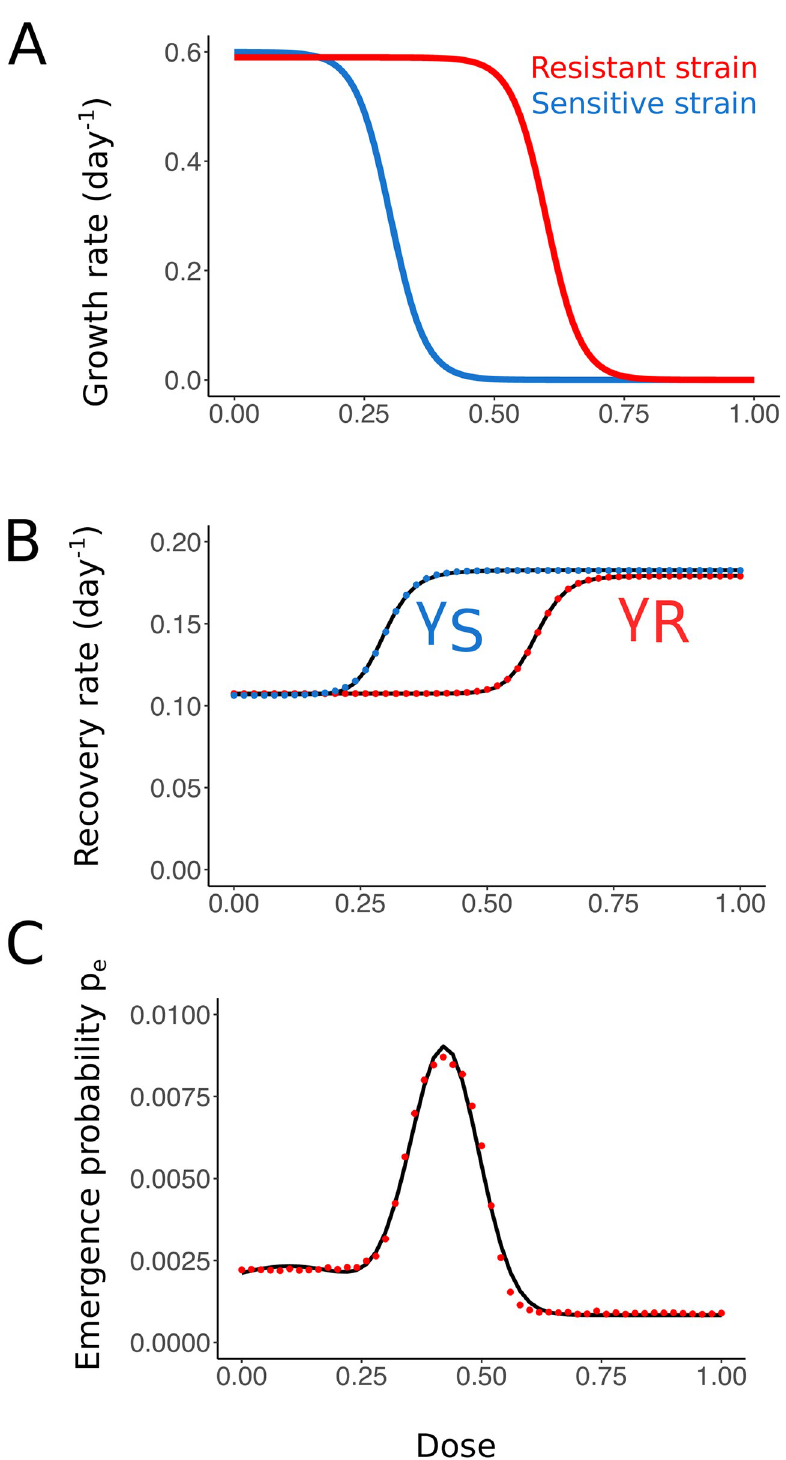
Fig 2. Transition from the nested agent-based model to an SIR model. (A) Effect of treatment strength on the growth rate for the sensitive and resistant strains. At very high doses, neither strain can grow in the presence of treatment. (B) Mean recovery rates of an individual infected by the sensitive (blue) and resistant (red) strain. Simulated results are fitted with sigmoid functions. (C) Probability of emergence of resistance as a function of dose, obtained from 2 × 10 6 within-host simulations per dose (red) and fitted with the sum of two Gaussians (black).